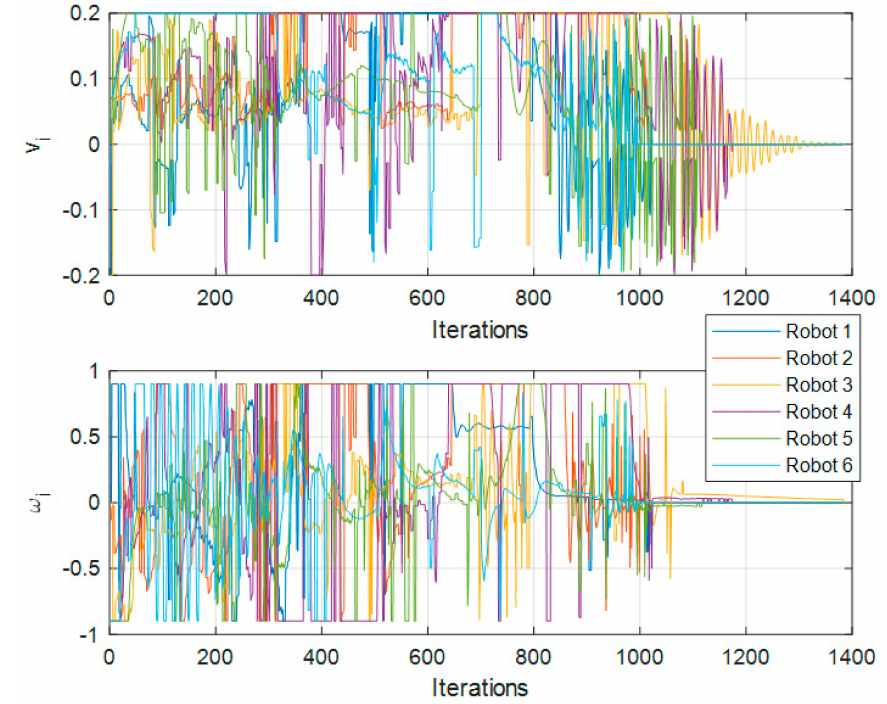
Figure 21. Input values for velocities in the 6-robot real-world